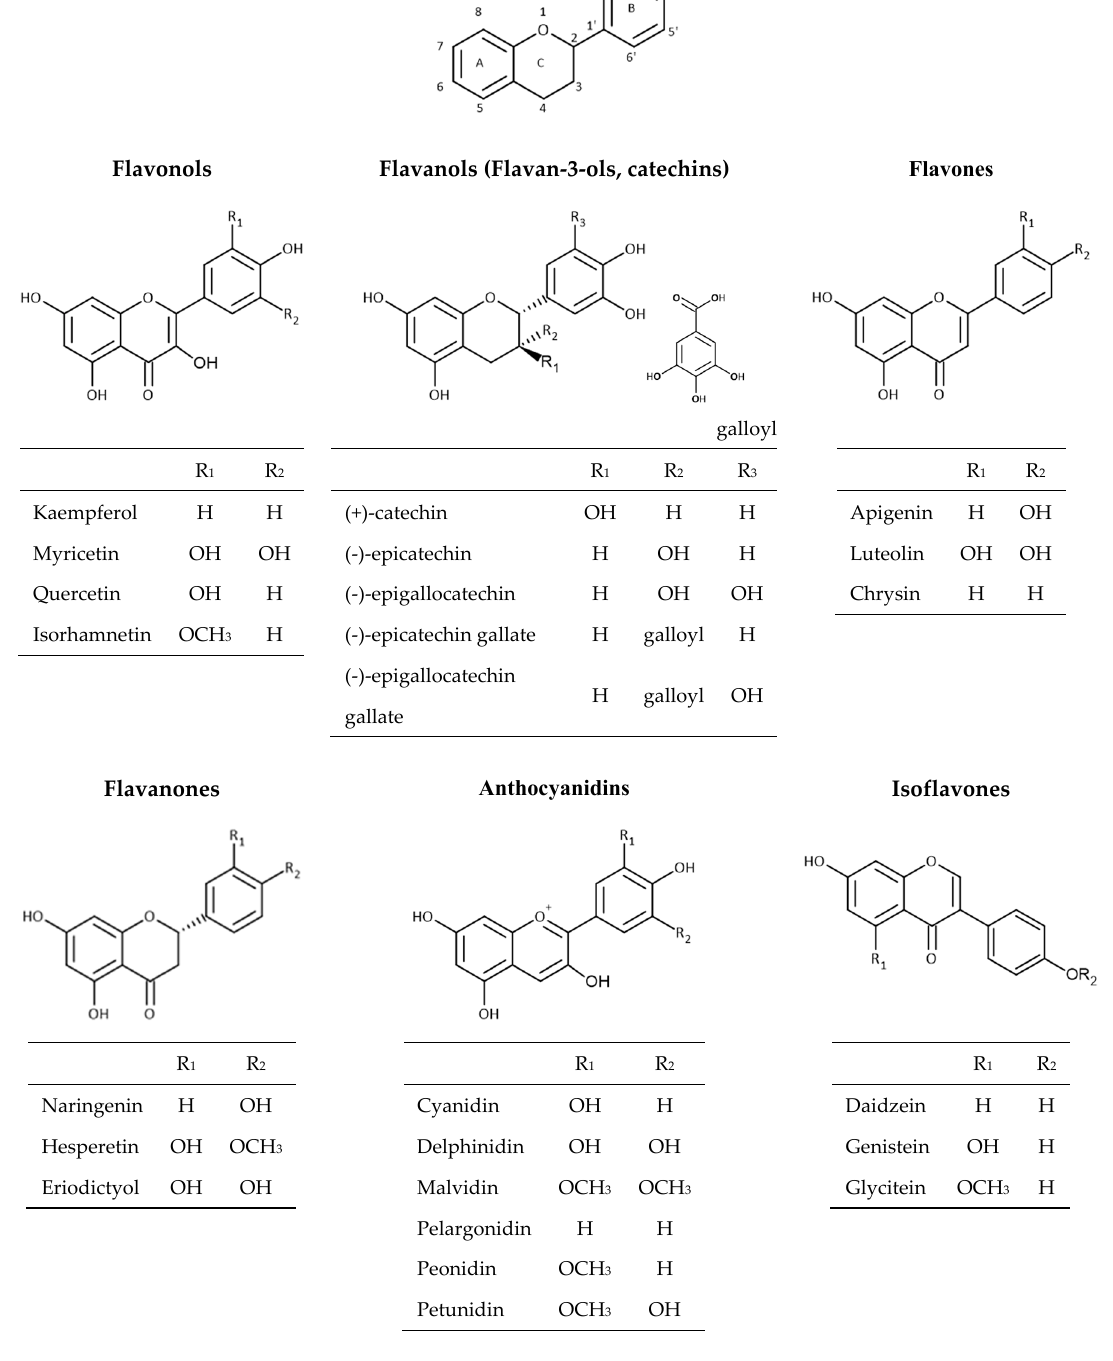
Figure 2. Chemical structures of flavonoids.